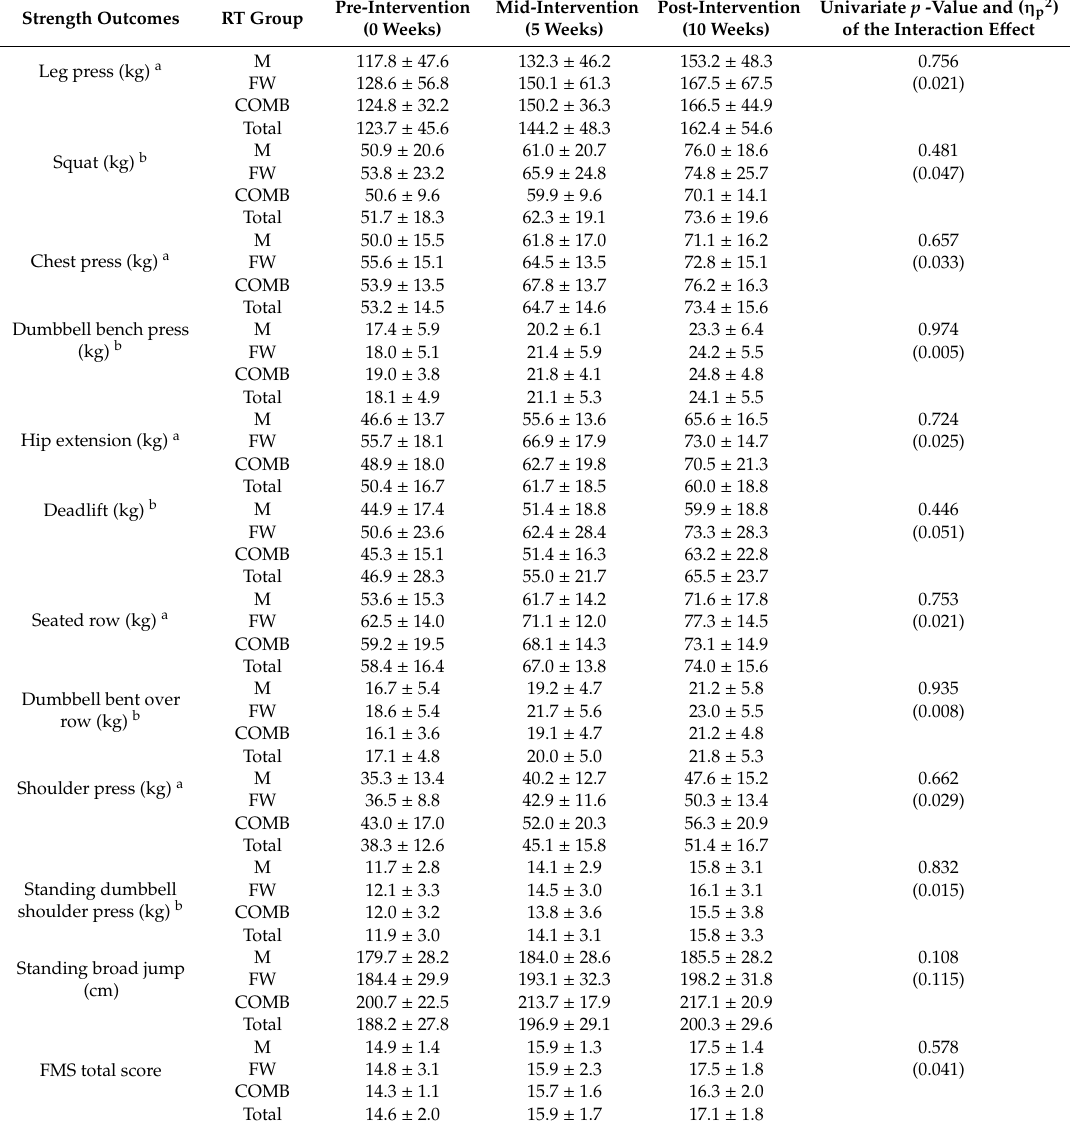
Table 4. Strength and functional ability assessments (means ± SD) according to RT group and time Strength